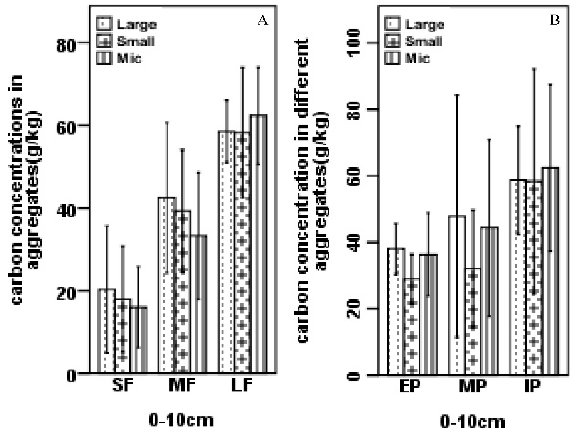
Figure 2. Soil carbon concentration in aggregates (g / kg) among di ff erent type of plots: ( A ) soil carbon concentration in aggregates (g / kg) among di ff erent forest fragments with di ff erent patch sizes; ( B ) soil carbon concentration in aggregates (g / kg) from forest edges to interiors.